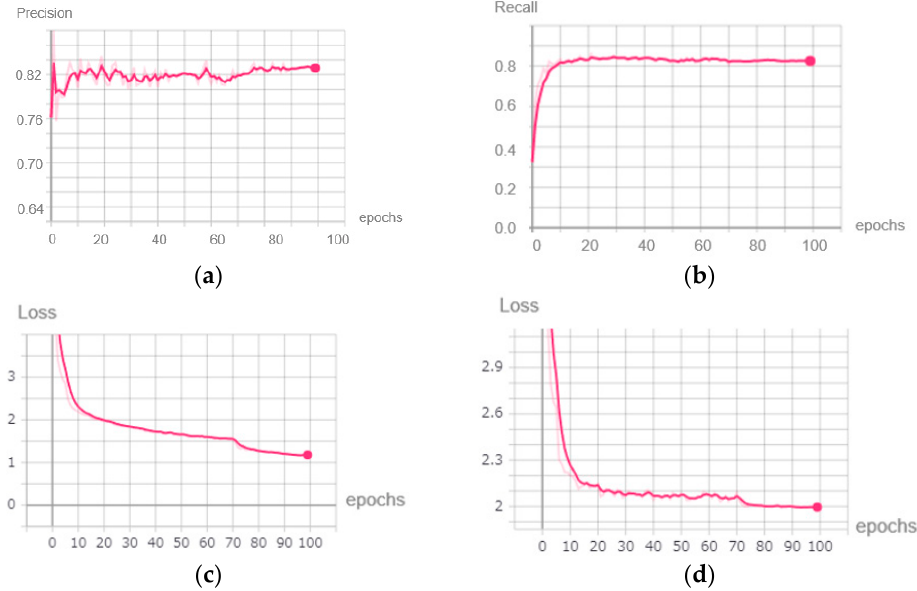
Figure 9. Metrics of the initial training stage. ( a ) Precision. ( b ) Recall. ( c ) Loss value of the training dataset. ( d ) Loss value of the testing dataset.